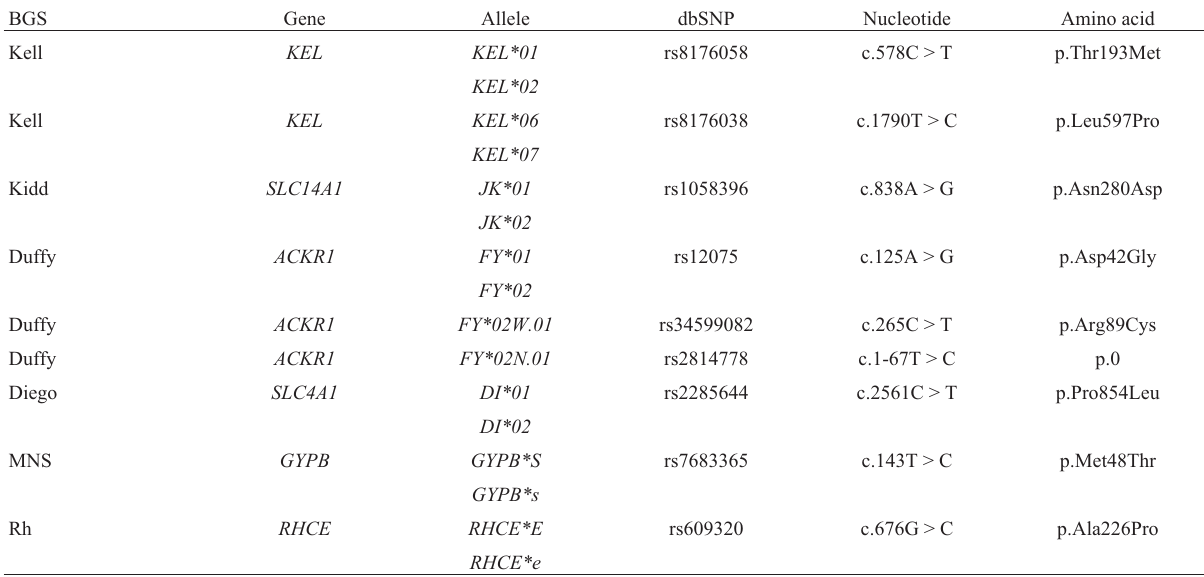
Table 1 - Characterization of blood groups alleles evaluated in present